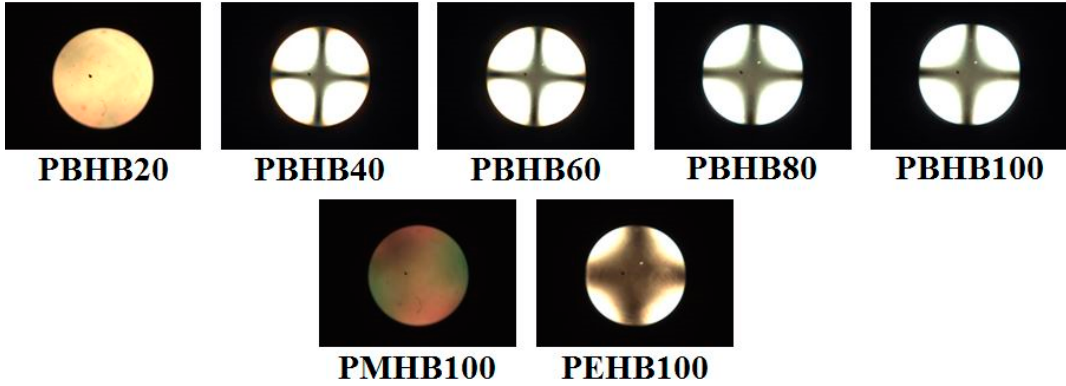
Figure 5. POM images of the LC cells made from PBHB# (PBHB20, PBHB40, PBHB60, PBHB80, and PBHB100) and PMHB100 and PEHB100 films.